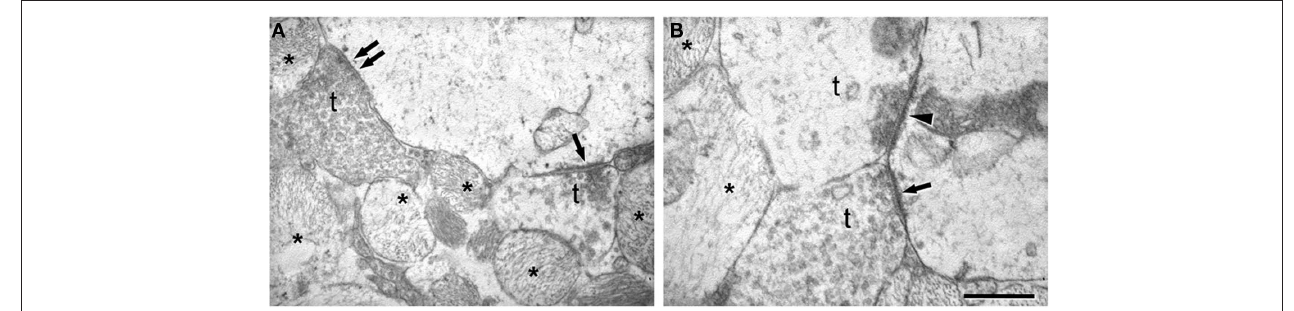
an asymmetric synapse established by a normal-looking axon terminal. The arrowhead points to an asymmetric synapse whose presynaptic axon terminal has an abnormal appearance and in which virtually all synaptic vesicles are close to the synaptic junction. In (A) and (B) , some processes of reactive glia are indicated by asterisks. t, axon terminal. Scale bar [in (B) ]: 0.5 μm in (A) and 0.4 μm in (B) .